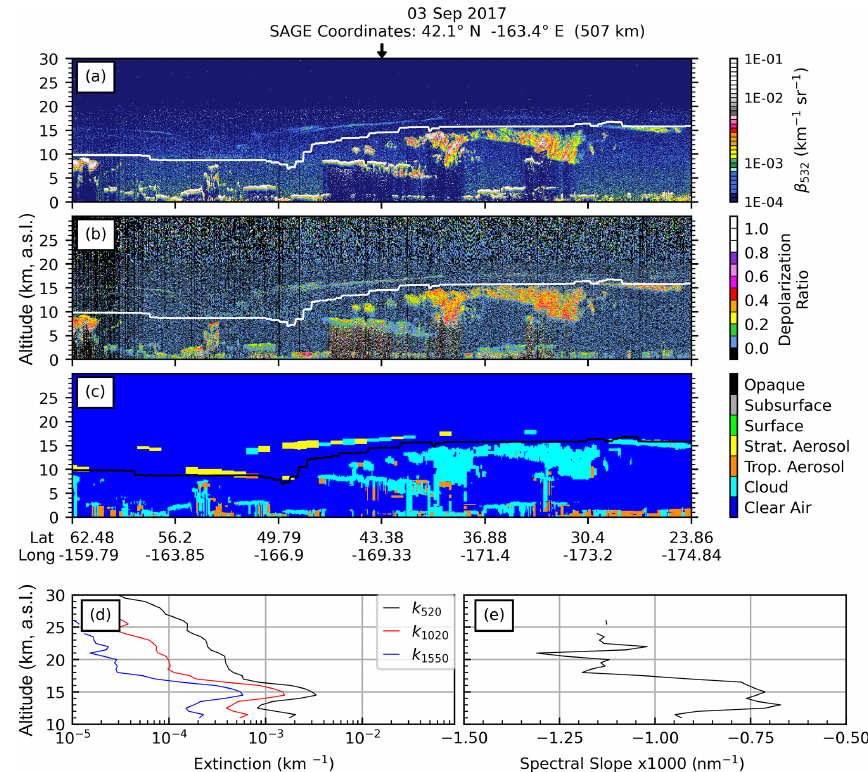
Figure 10. Same as Fig. 6, but for the Canadian pyroCb. The CALIOP granule used to generate this image is CAL_LID_L1-Standard-V4-